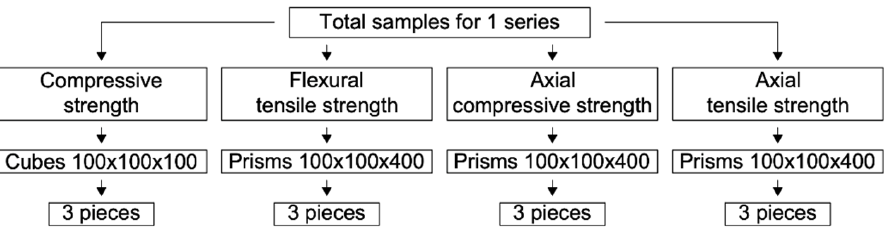
Figure 2. Experimental research program.